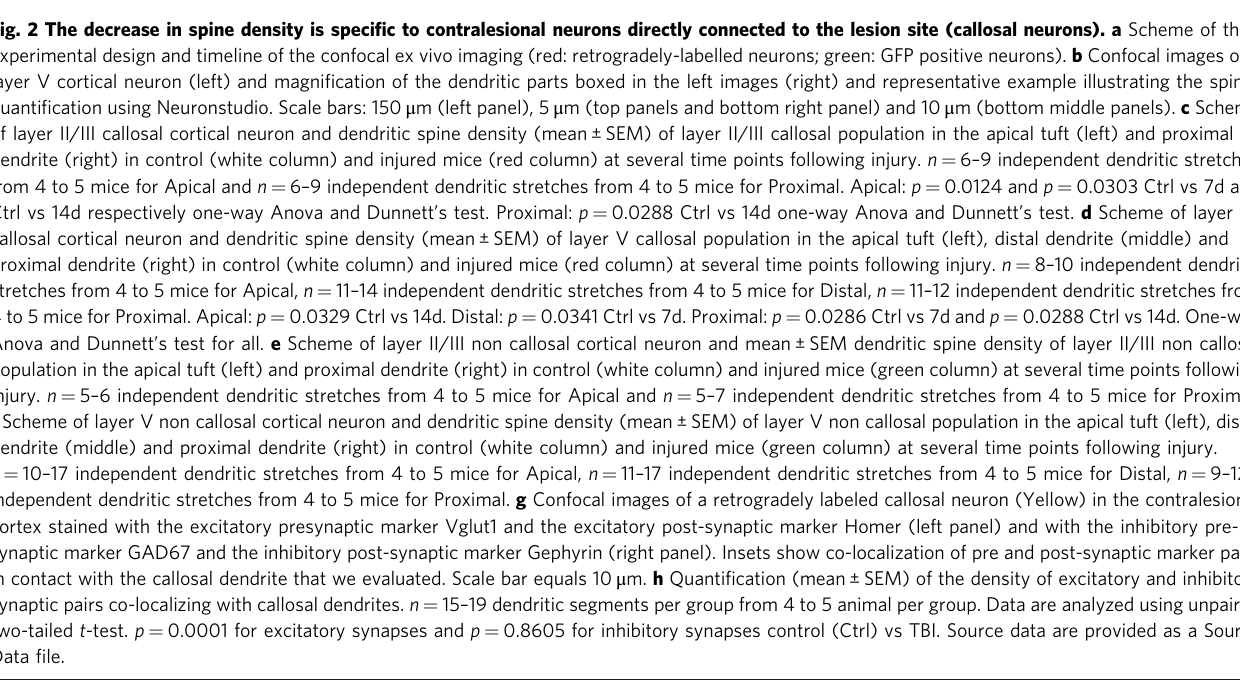
Fig. 2 The decrease in spine density is speci fi c to contralesional neurons directly connected to the lesion site (callosal neurons). a Scheme of the experimental design and timeline of the confocal ex vivo imaging (red: retrogradely-labelled neurons; green: GFP positive neurons). b Confocal images of a layer V cortical neuron (left) and magni fi cation of the dendritic parts boxed in the left images (right) and representative example illustrating the spine quanti fi cation using Neuronstudio. Scale bars: 150 μ m (left panel), 5 μ m (top panels and bottom right panel) and 10 μ m (bottom middle panels). c Scheme of layer II/III callosal cortical neuron and dendritic spine density (mean ± SEM) of layer II/III callosal population in the apical tuft (left) and proximal dendrite (right) in control (white column) and injured mice (red column) at several time points following injury. n = 6 – 9 independent dendritic stretches from 4 to 5 mice for Apical and n = 6 – 9 independent dendritic stretches from 4 to 5 mice for Proximal. Apical: p = 0.0124 and p = 0.0303 Ctrl vs 7d and Ctrl vs 14d respectively one-way Anova and Dunnett ’ s test. Proximal: p = 0.0288 Ctrl vs 14d one-way Anova and Dunnett ’ s test. d Scheme of layer V callosal cortical neuron and dendritic spine density (mean ± SEM) of layer V callosal population in the apical tuft (left), distal dendrite (middle) and proximal dendrite (right) in control (white column) and injured mice (red column) at several time points following injury. n = 8 – 10 independent dendritic stretches from 4 to 5 mice for Apical, n = 11 – 14 independent dendritic stretches from 4 to 5 mice for Distal, n = 11 – 12 independent dendritic stretches from 4 to 5 mice for Proximal. Apical: p = 0.0329 Ctrl vs 14d. Distal: p = 0.0341 Ctrl vs 7d. Proximal: p = 0.0286 Ctrl vs 7d and p = 0.0288 Ctrl vs 14d. One-way Anova and Dunnett ’ s test for all. e Scheme of layer II/III non callosal cortical neuron and mean ± SEM dendritic spine density of layer II/III non callosal population in the apical tuft (left) and proximal dendrite (right) in control (white column) and injured mice (green column) at several time points following injury. n = 5 – 6 independent dendritic stretches from 4 to 5 mice for Apical and n = 5 – 7 independent dendritic stretches from 4 to 5 mice for Proximal. f Scheme of layer V non callosal cortical neuron and dendritic spine density (mean ± SEM) of layer V non callosal population in the apical tuft (left), distal dendrite (middle) and proximal dendrite (right) in control (white column) and injured mice (green column) at several time points following injury. n = 10 – 17 independent dendritic stretches from 4 to 5 mice for Apical, n = 11 – 17 independent dendritic stretches from 4 to 5 mice for Distal, n = 9 – 12 independent dendritic stretches from 4 to 5 mice for Proximal. g Confocal images of a retrogradely labeled callosal neuron (Yellow) in the contralesional cortex stained with the excitatory presynaptic marker Vglut1 and the excitatory post-synaptic marker Homer (left panel) and with the inhibitory pre- synaptic marker GAD67 and the inhibitory post-synaptic marker Gephyrin (right panel). Insets show co-localization of pre and post-synaptic marker pairs in contact with the callosal dendrite that we evaluated. Scale bar equals 10 μ m. h Quanti fi cation (mean ± SEM) of the density of excitatory and inhibitory synaptic pairs co-localizing with callosal dendrites. n = 15 – 19 dendritic segments per group from 4 to 5 animal per group. Data are analyzed using unpaired two-tailed t -test. p = 0.0001 for excitatory synapses and p = 0.8605 for inhibitory synapses control (Ctrl) vs TBI. Source data are provided as a Source Data fi